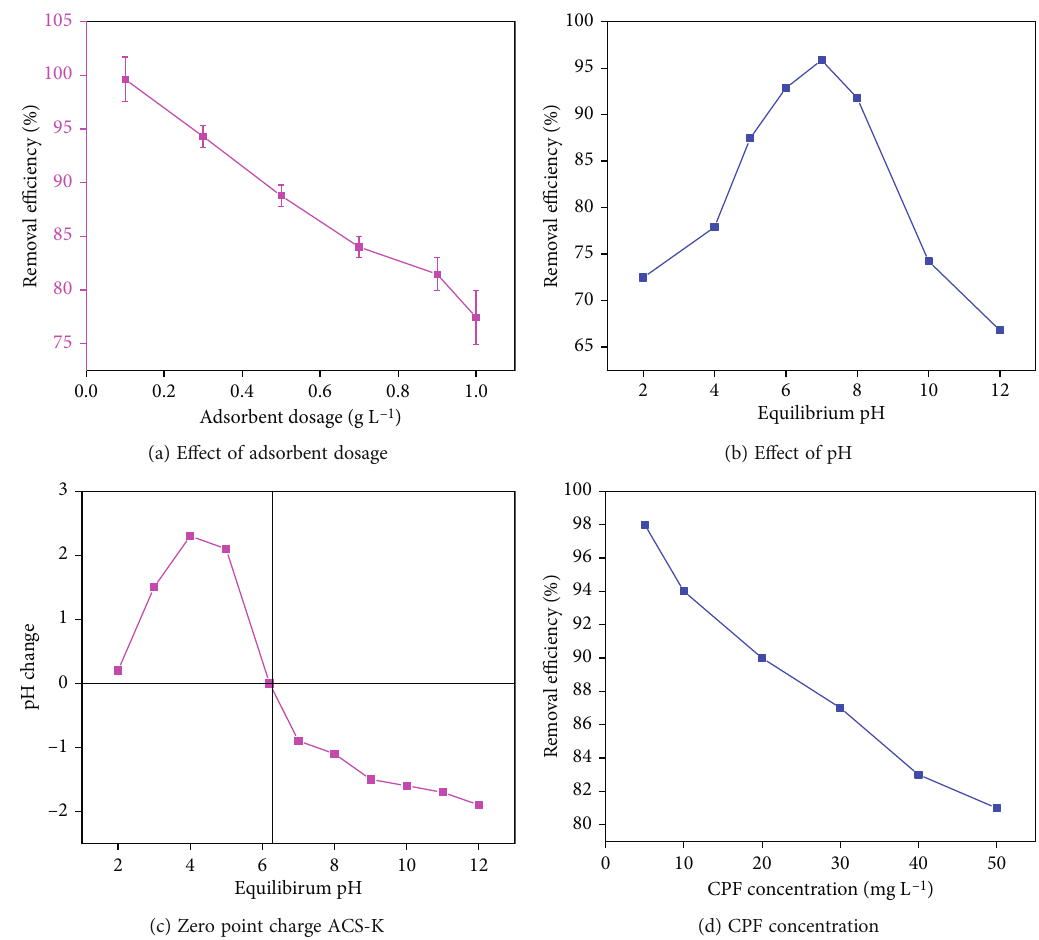
Figure 5: (a, b) E ff ect of adsorbent dosage and equilibrium pH in removing CPF from water, (c) zero point charge of ACS-K, and (d) e ff ect of CPF concentration with respect to removal. Table 1: Parameters estimated in adsorption kinetics in removing